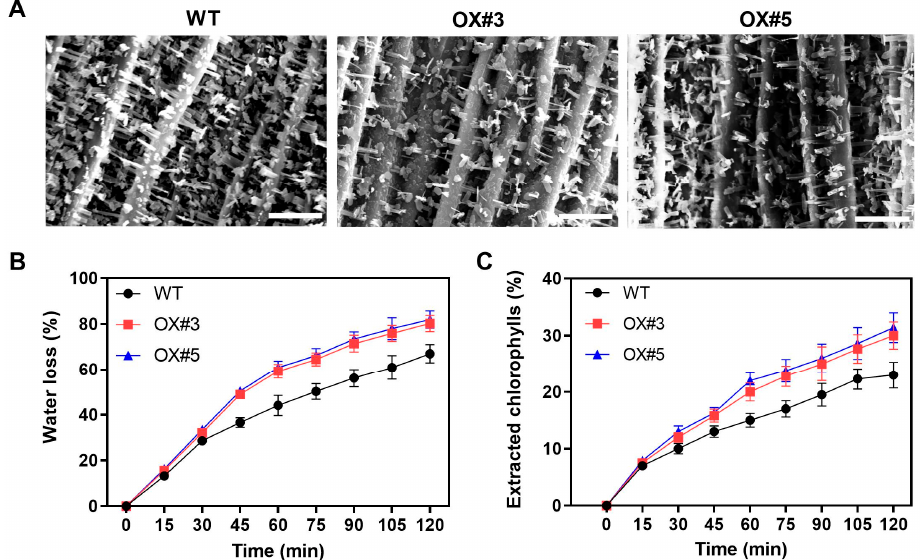
Figure 6. Epicuticular wax crystal structure and cuticle permeability in WT and BnaC9.DEWAX1 overexpression lines. ( A ) Scanning electron microscope images of epicuticular waxes on the top of inflorescence stem surface. Scale bars = 10 μ m. ( B ) Water-loss rates of isolated six-week-old rosettes. ( C ) Chlorophyll extraction rates of isolated six-week-old rosettes. Error bars indicate ± SD of five replicates.